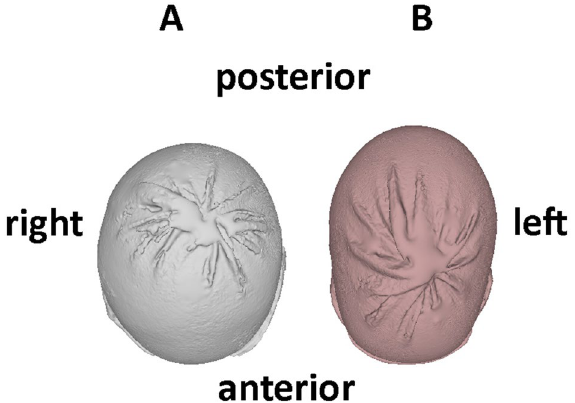
Figure 3. Transversal view of representative head shapes based on median head shape parameters of term infants (A) exhibiting a cranial index of 84.3% and a cranial volume of 735 cm 3 compared to preterm infants (B) with a cranial index of 69.6% and a cranial volume of 738.7 cm 3 .